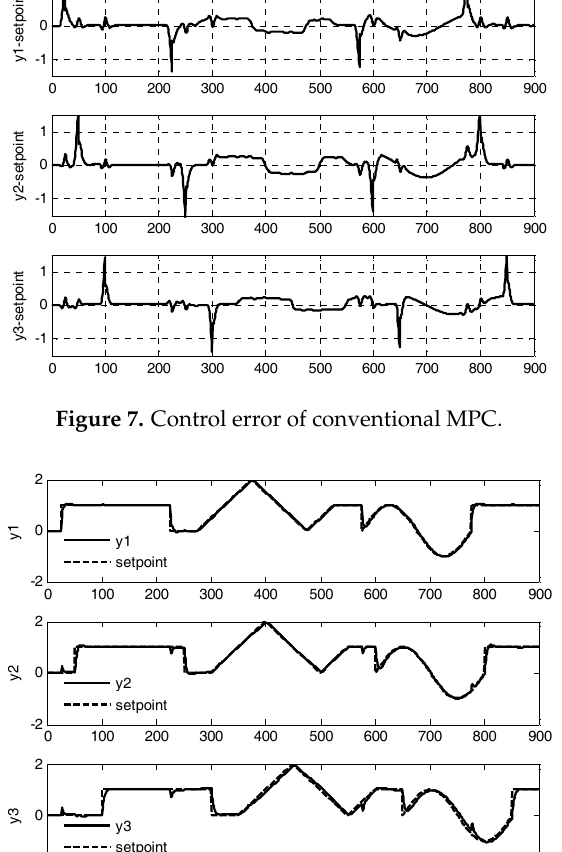
Figure 9. Control error of conventional MPC in dynamic PLS.